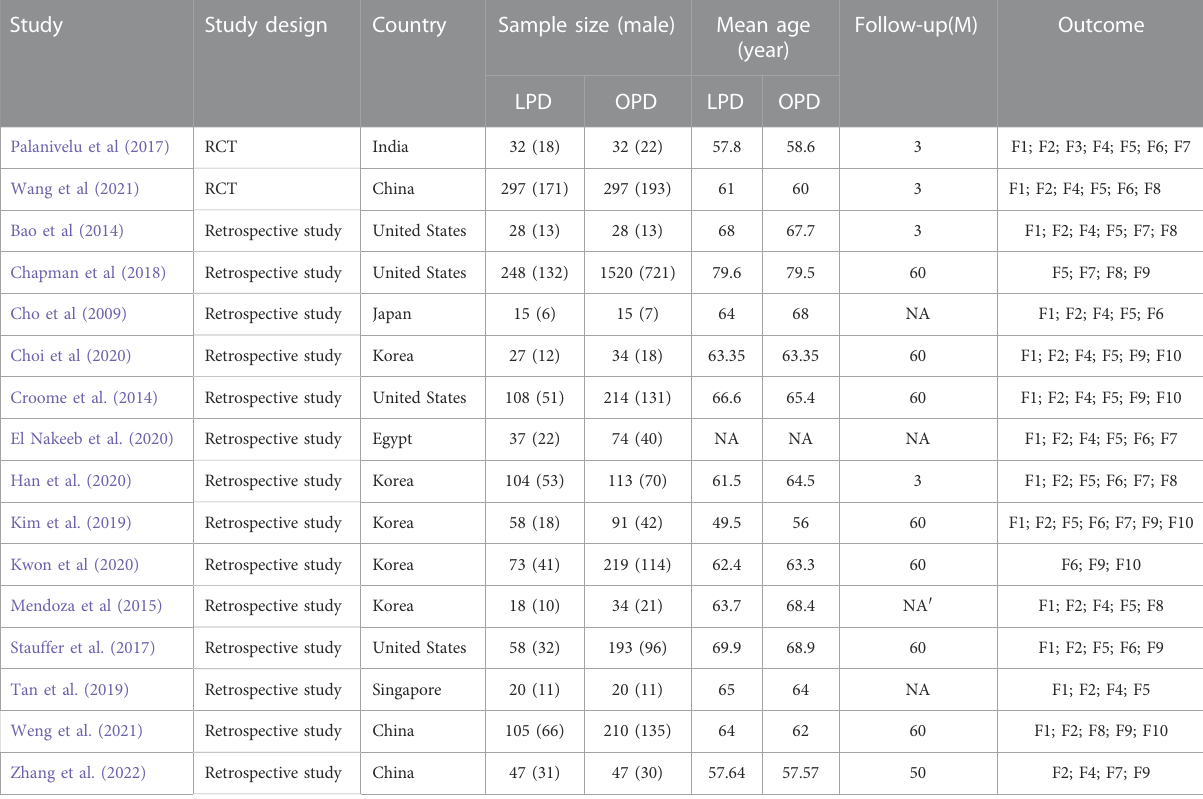
TABLE 1 Characteristics of studies